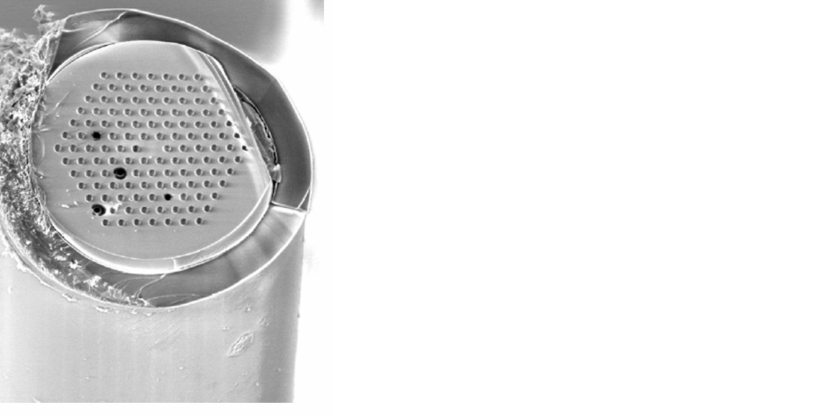
Figure 5. Scanning electron micrograph of MLC containing 126 parallel channels. (Reprinted with permission from [66], published by the American Chemical Society (Washington, DC, USA),